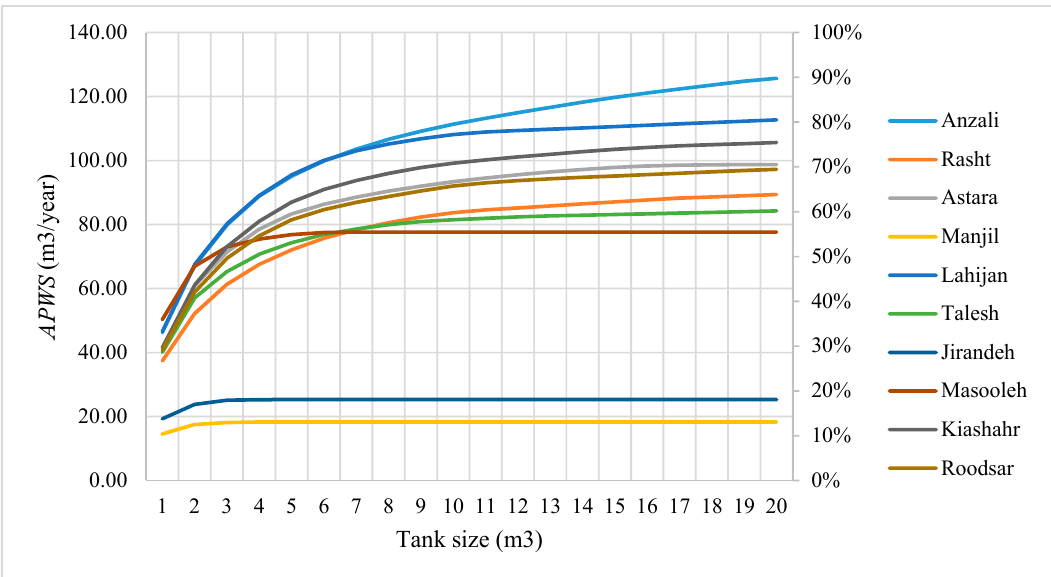
Figure 5. The relation between tank size and APWS for all stations (Scenario B).